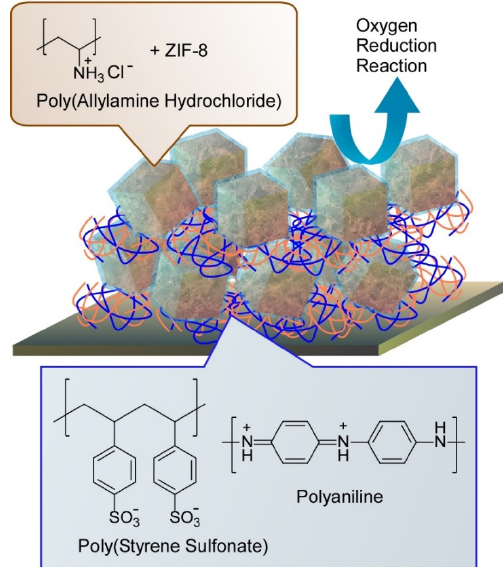
Figure 20. Nanoarchitectonics approach on the basis of layer-by-layer (LbL) assembly of conduc- tive polymers and MOF complexes for better oxygen reduction